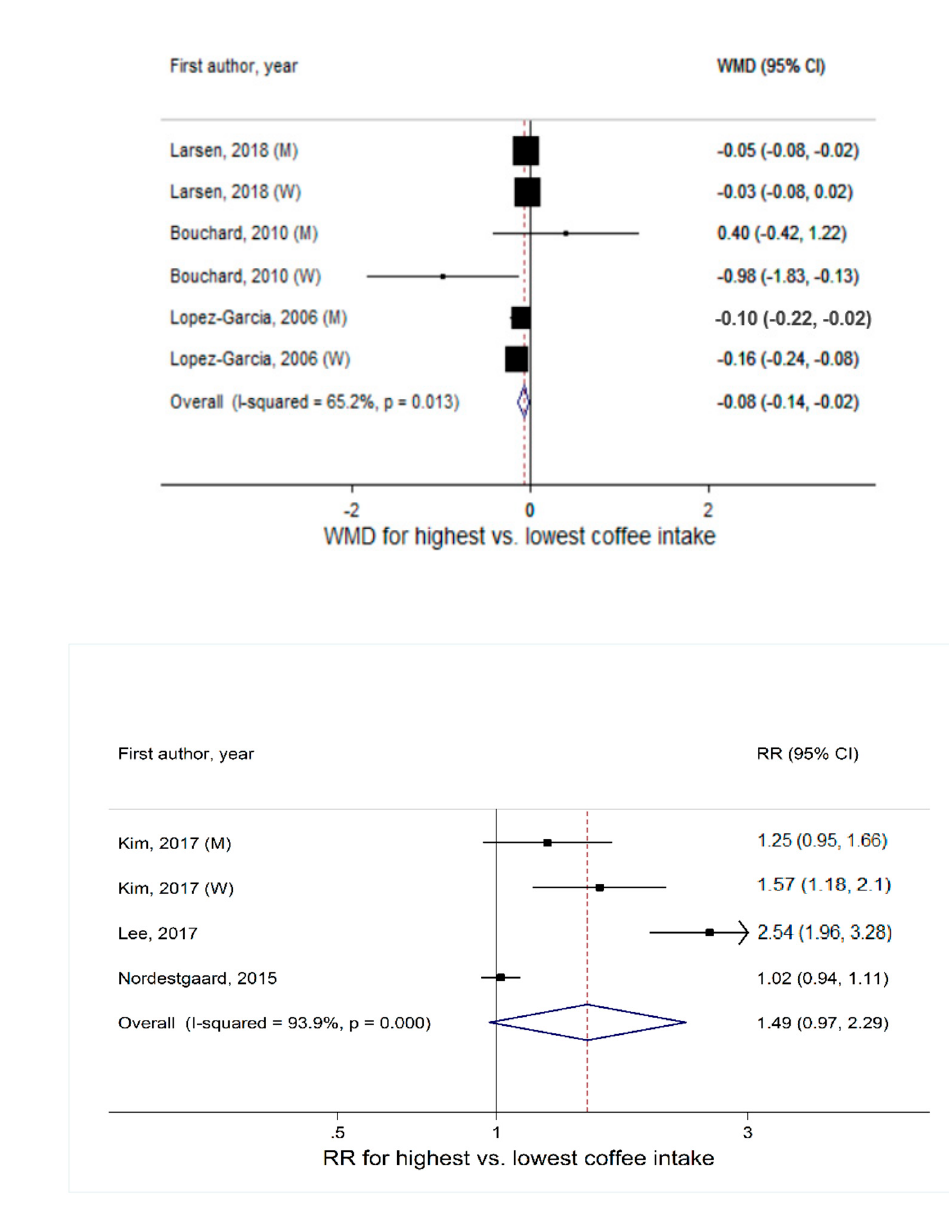
Figure 2. Meta-analysis of coffee intake with ( A ) continuous BMI and ( B ) overall obesity defined by BMI. Abbreviations: BMI, body mass index; CI, confidence interval; M, men; RR, relative risk; W, women; WMD, weighted mean difference.